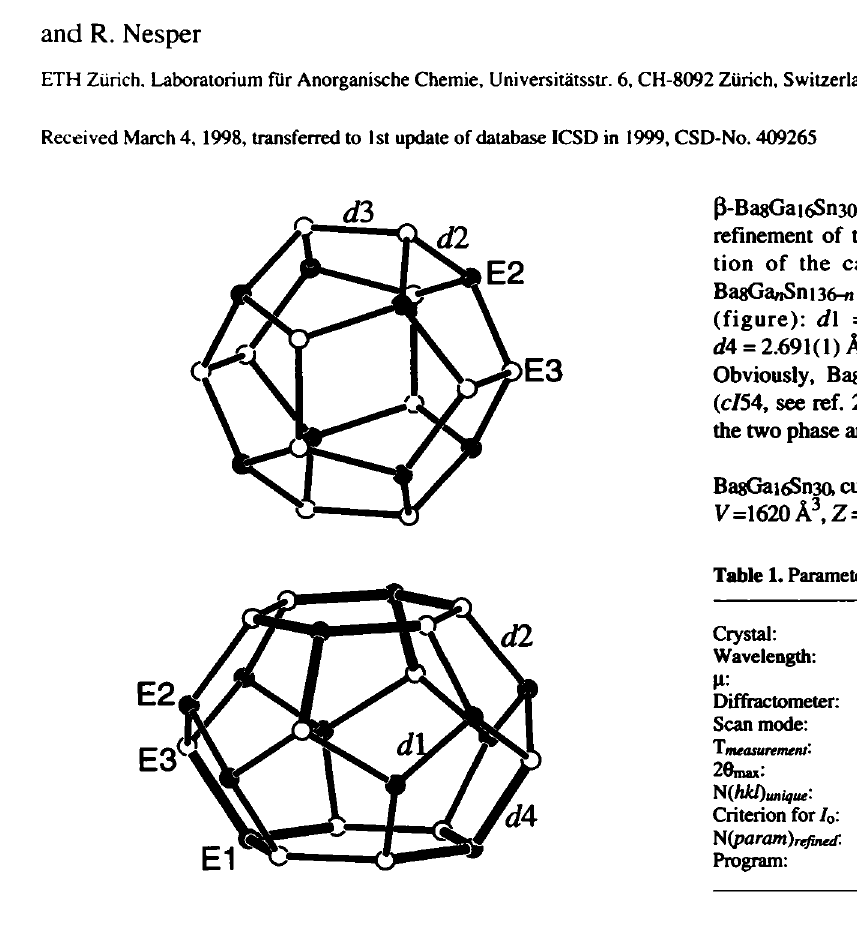
Table 1. Parameters used for the X-ray data collection Crystal: